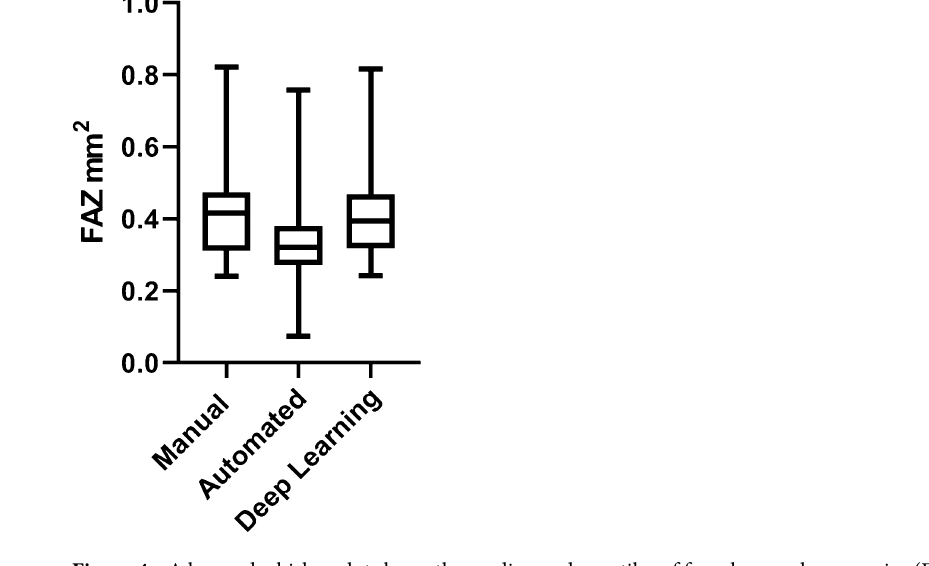
Figure 4. A bar and whisker plot shows the median and quartiles of foveal avascular zone size (FAZ), measured by three different methods. The automated FAZ size was significantly smaller than the areas measured by manual and deep learning methods ( P value < 0.000).